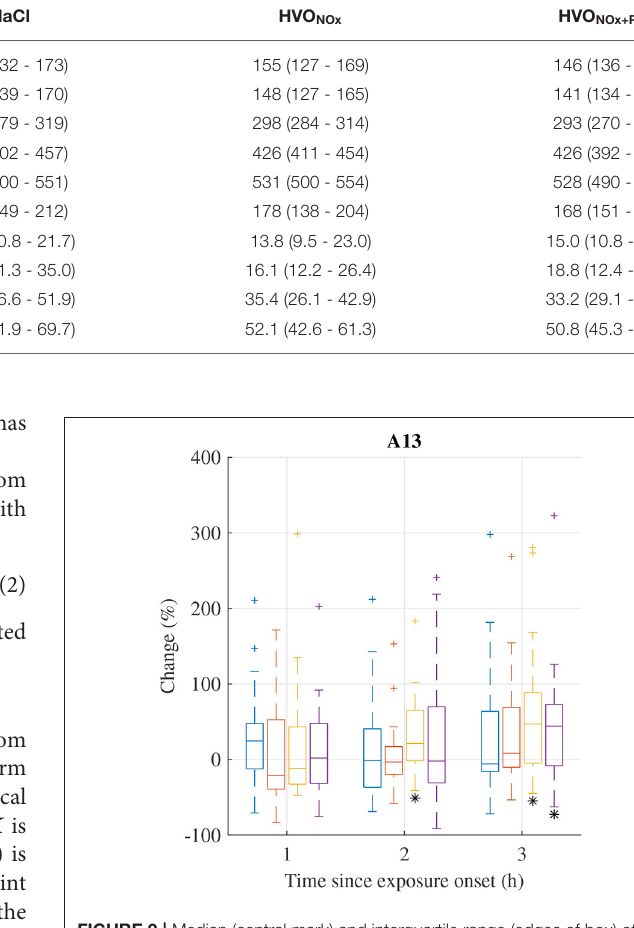
FIGURE 2 | Median (central mark) and interquartile range (edges of box) of relative change 1 ( F i ) t of A 13 during exposure scenario FA (blue), NaCl (red), HVO NOx (yellow), and HVO NOx+PM (purple). Whiskers extend to 1.5 times the interquartile range and values outside this interval are marked by “+.” 1 ( F i ) t significantly different from zero according to the Wilcoxon signed rank test (p < 0.05) are marked by